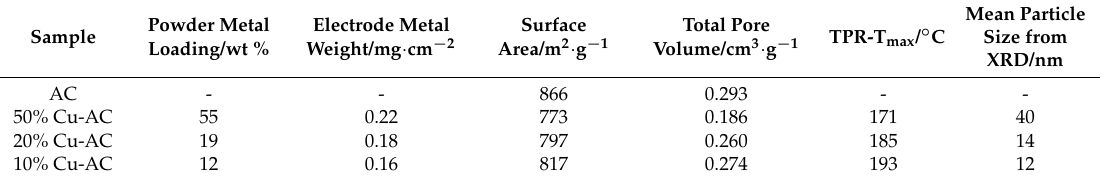
Table 1. Physicochemical properties of the support material, the catalysts, and the fresh electrodes.